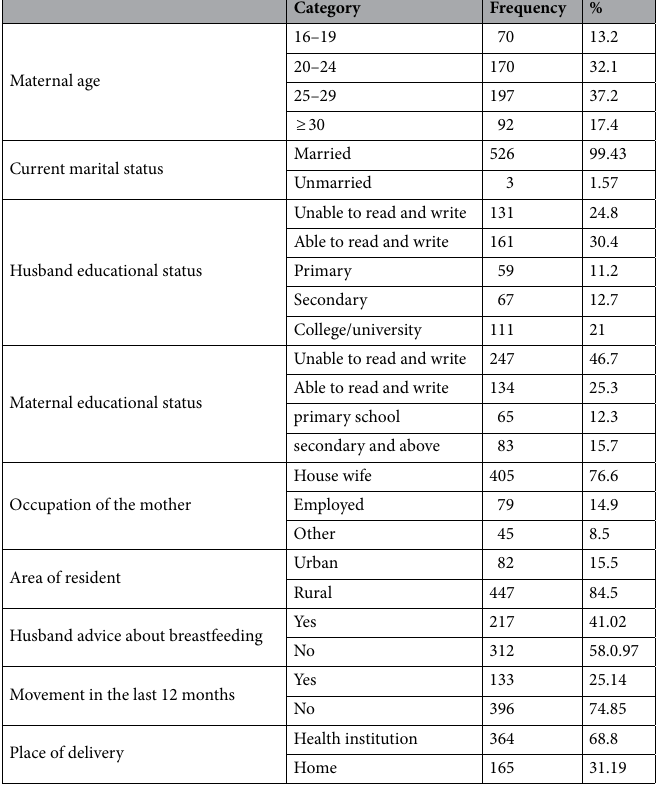
Table 1. Socio-demographic characteristics of respondents in chereti district Afder zone southeastern Ethiopia, 2019 (n =